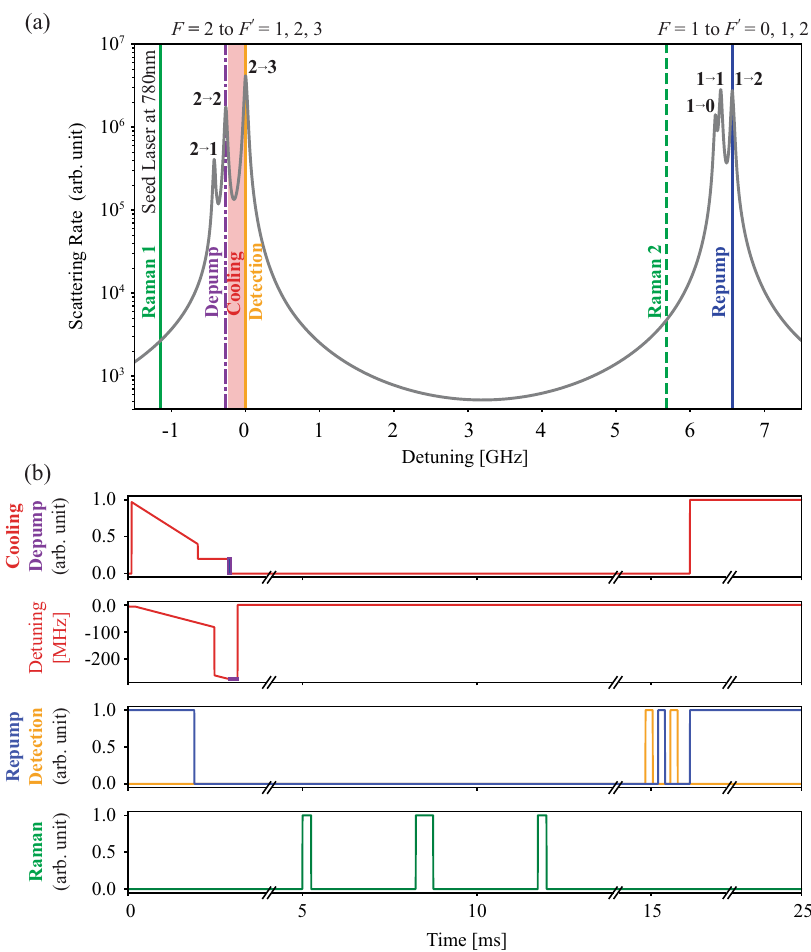
Fig. 5 Optical frequency and timing diagram for the PIC-compatible laser system. a Optical transitions of 87 Rb atoms (D2 transition) 79 for LPAI operation. Cooling, Detection, Depump, and Raman 1 beams use F ¼ 2 j i to F 0 ¼ 1 ; 2 ; 3 j i transitions (Left peaks), and Repump and Raman 2 beams use F ¼ 1 j i to F 0 ¼ 0 ; 1 ; 2 j i transitions (Right peaks). The 1560 nm seed laser is frequency-doubled to 780 nm and locked to F ¼ 2 j i to F 0 ¼ 2 ; 3 j i crossover transition with ~1.15 GHz red-detuning from the F ¼ 2 j i ! F 0 ¼ 3 j i resonance, which is also used for Raman 1. b Diagram of the timing sequence for LPAI operation highlighting important dynamic changes in the laser channels. The pulse width of Repump/Detection/Raman is not to scale.